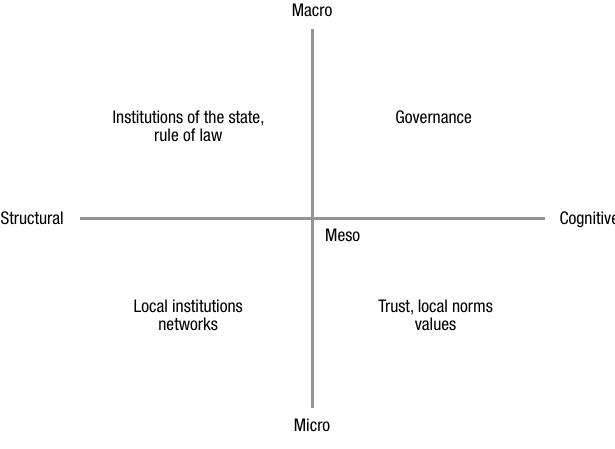
Fig. 1. The forms and scope of social capital Source: Grootaert, Van Bastelaer (2002: